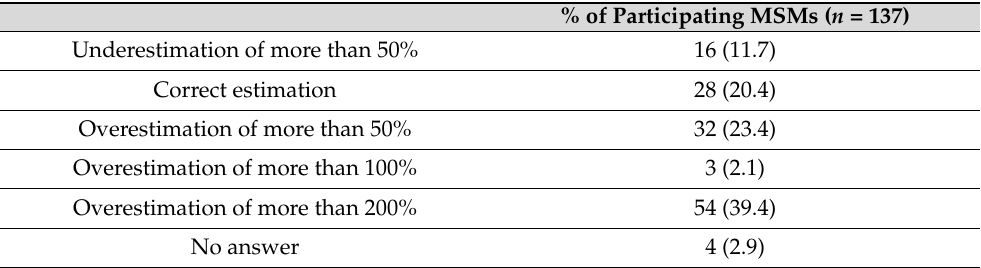
Table 6. Perceived incidence of stress-ulcer induced GI-bleeding. Participating MSMs were asked to estimate the incidence of stress ulcer-induced GI bleeding in intensive care patients. Answers within an error range of ± 50% of the incidence found in the literature (2.7%) 26 were considered